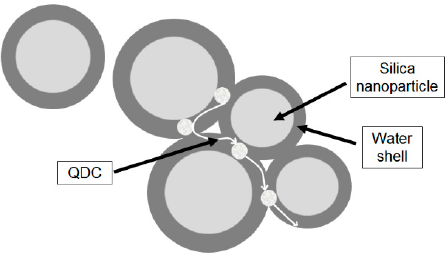
passes through overlapping water shells, around nanoparticles (Redraw and adapted figure from [87]).